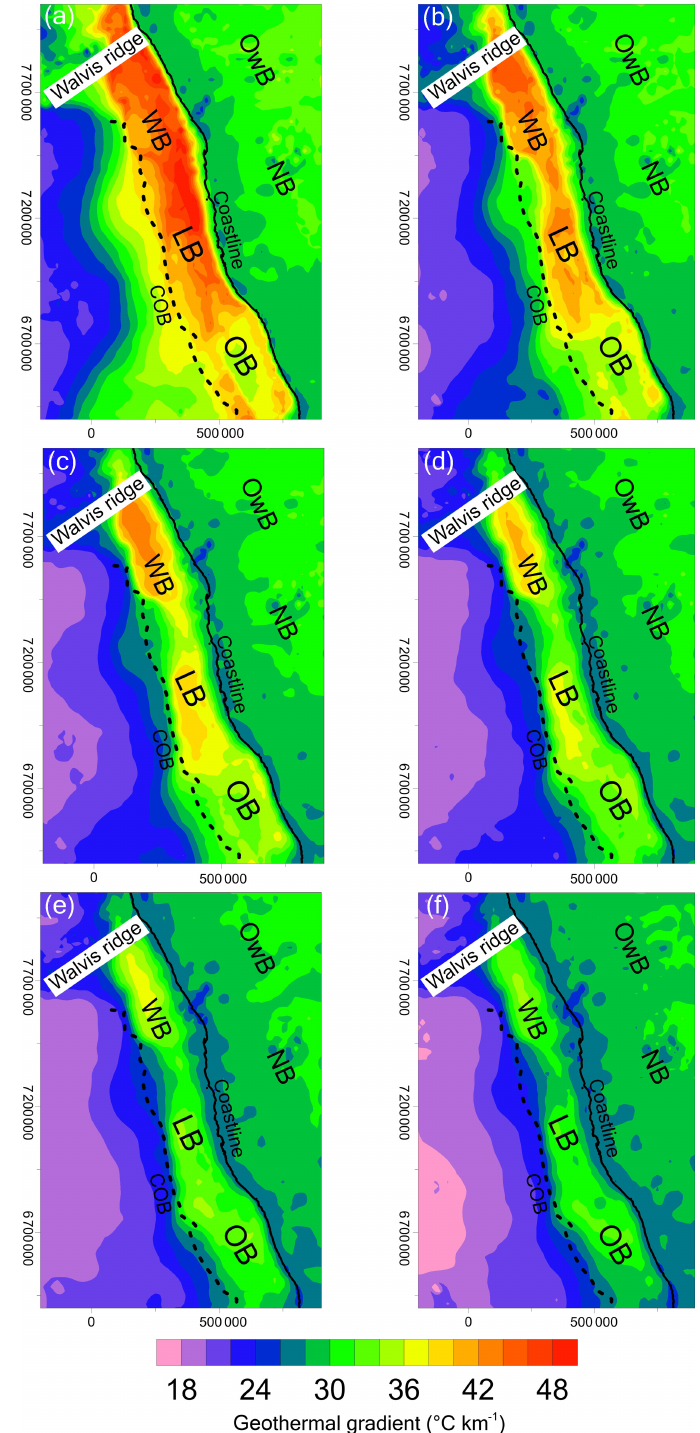
Figure 8. Geothermal gradient ( ◦ Ckm − 1 ) at the SW African margin: the gradient calculated as the temperature differences between the uppermost surface (upper thermal boundary) and the corresponding temperature distribution at (a) 1, (b) 2, (c) 3, (d) 4, (e) 5, and (f) 6km below the uppermost surface (COB: continent–ocean boundary; Cretaceous–Cenozoic basins: WB: Walvis Basin, LB: Lüderitz Basin, OB: Orange Basin; Precambrian basins: OwB: Owambo Basin, NB: Nama Basin; UTM: WGS84, 33S).